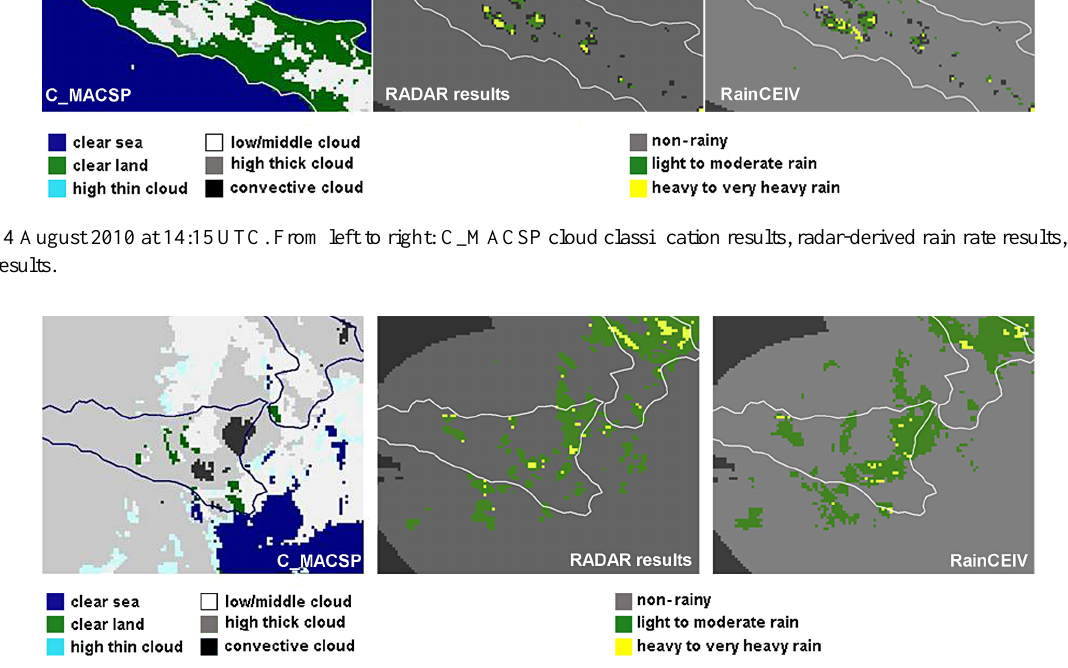
Figure 5. 21 February 2013 at 15:00UTC. From left to right: C_MACSP cloud classification results, radar-derived rain rate results, RainCEIV rain rate